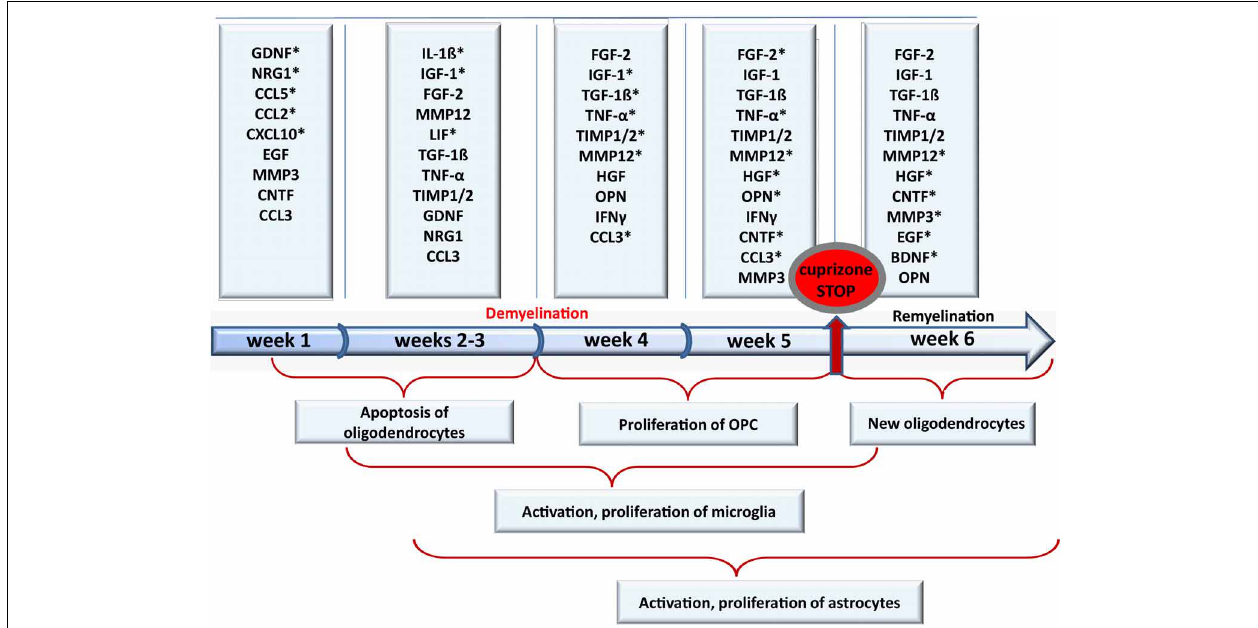
FIGURE 3 | Growth factors, cytokines, chemokines, and MMP expressed in the medial corpus callosum during cuprizone-induced de- and remyelination. The expression (mostly mRNA expression) of different growth factors, cytokines, chemokines, and MMP were summarized from different studies where 0.2% (w/w) cuprizone was fed for 5 to 8–10-week old